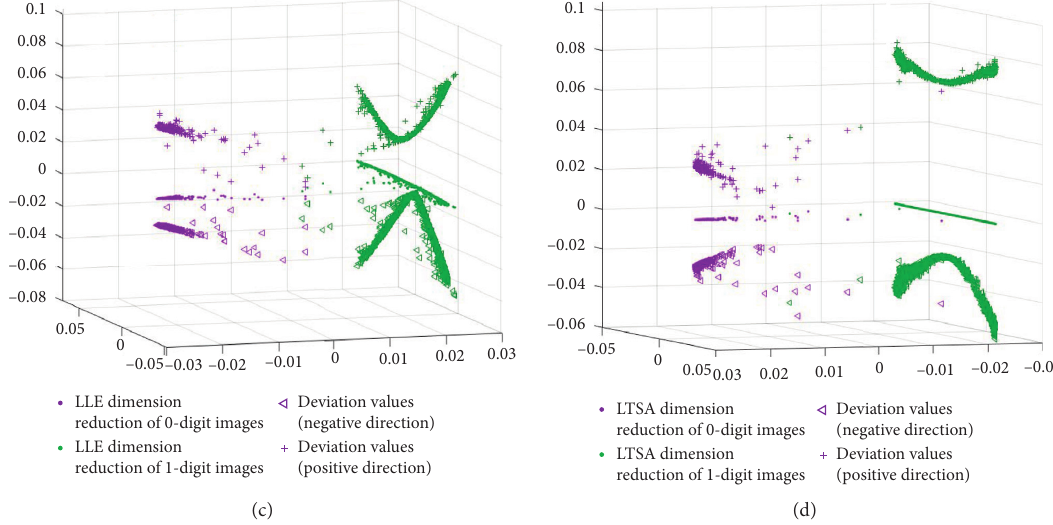
Figure 16: Manifold dimension reduction results of “0” and “1” and results of deviation values.